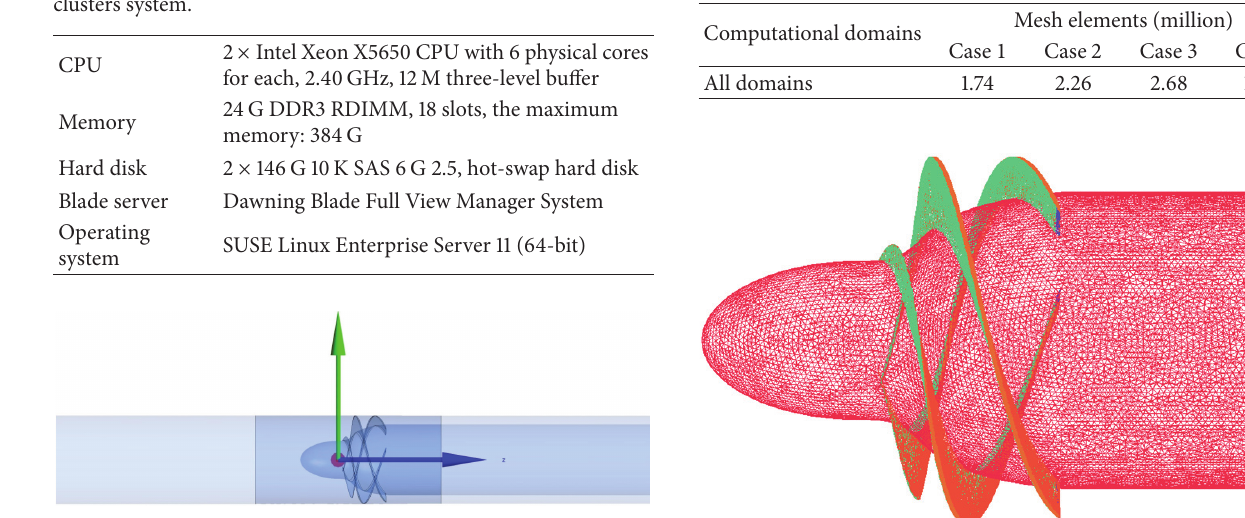
Figure 1: Three-dimensional model of the inducer.